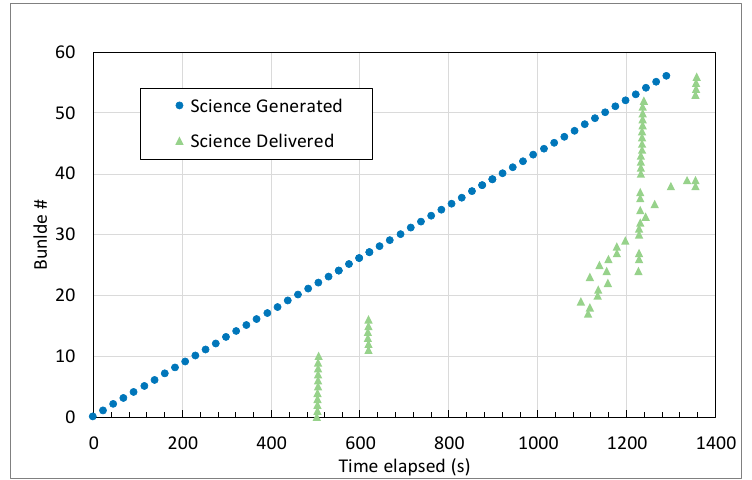
Figure 9. Science data flow (bulk priority) from Lander to PDGS: time sequences of bundle generation and delivery. Direct delivery by means of DTNperf.